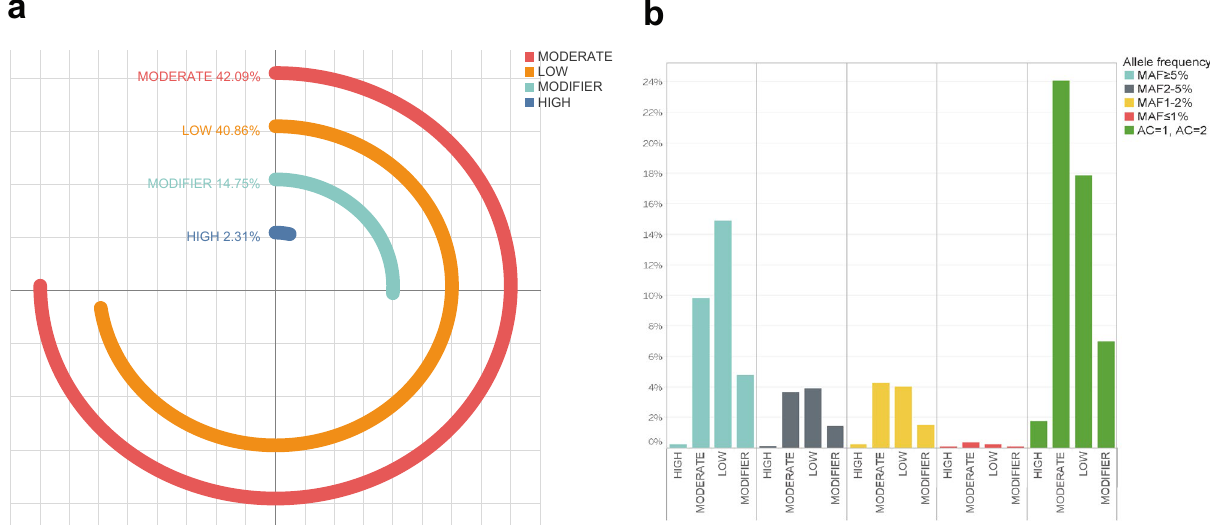
Figure 2. Functional effects of variants in the Serbian population sample (a). The distribution of variants across predicted categories. Modifiers and high functional impact variants are predicted for 17.06% of variants. The vast majority of variants are predicted to have moderate and low functional impact. ( b) MAF categories are divided into functional impact subcategories. The value on the y-axis represents the number of variants. For each MAF category there are functional impact subcategories: high, moderate, low, and modifier.